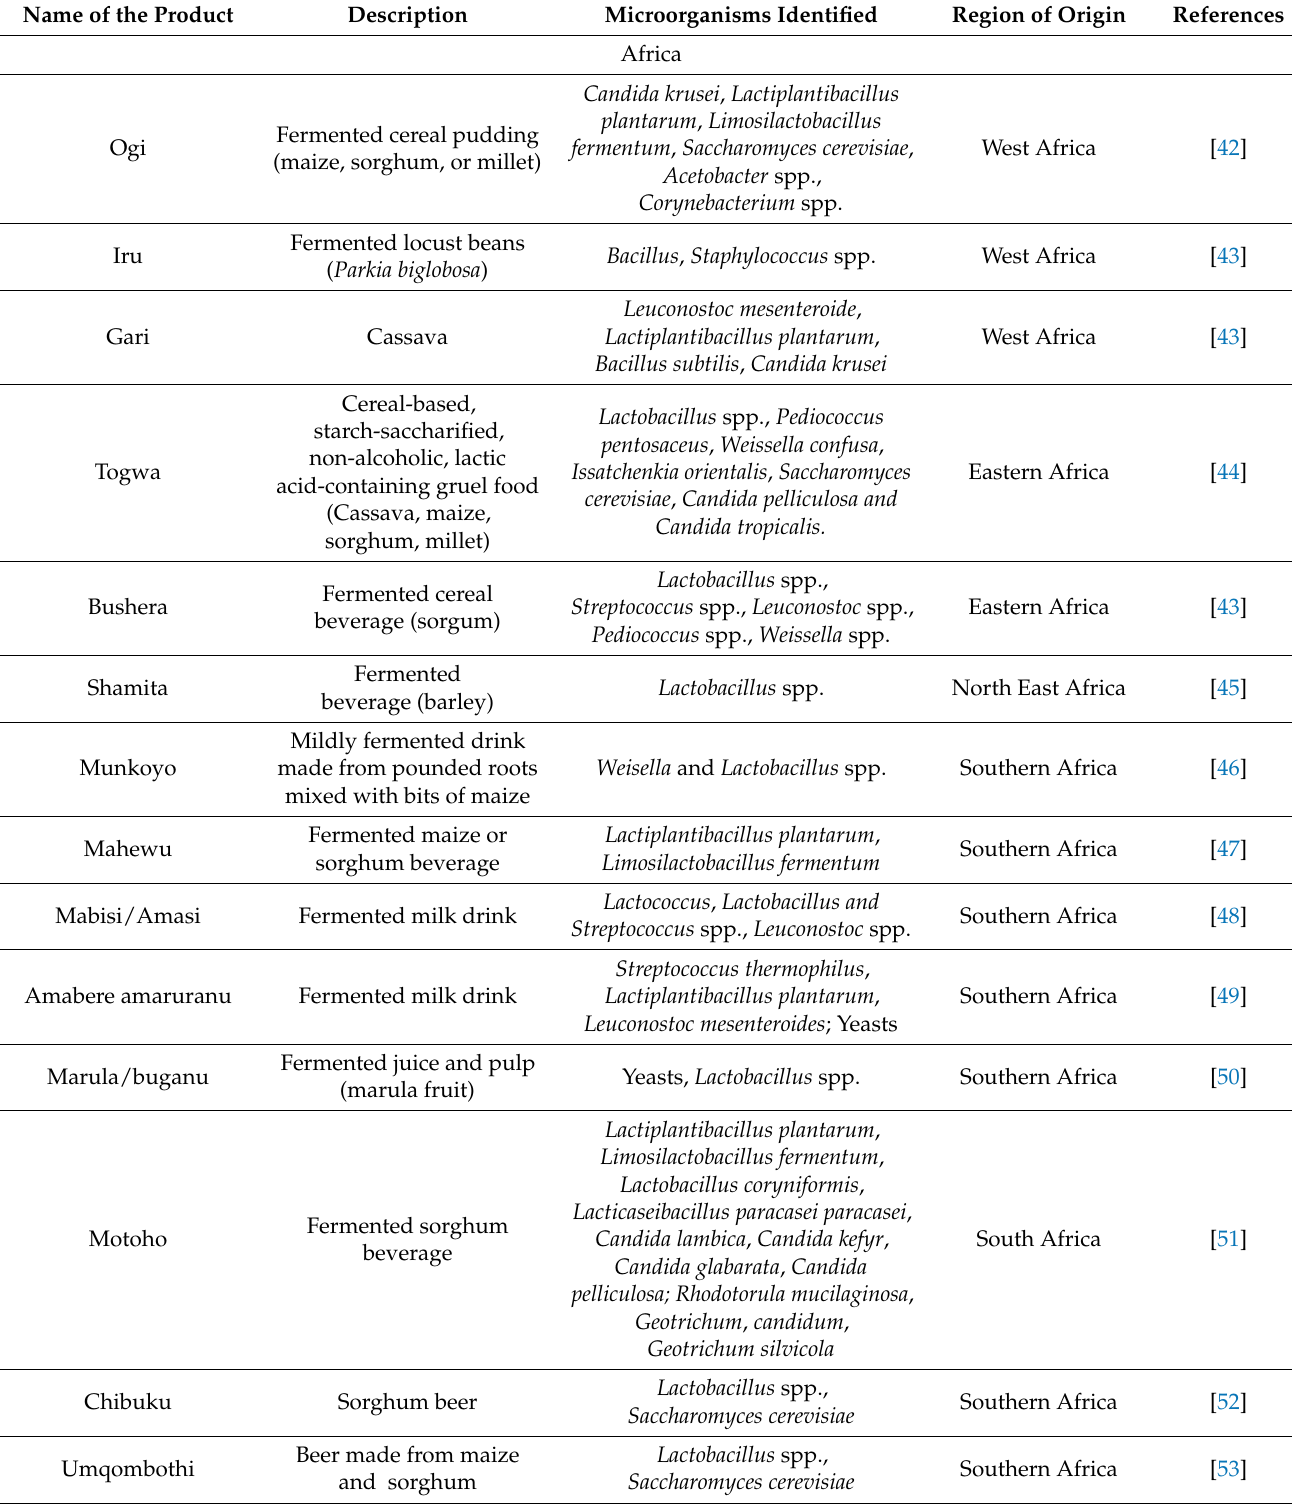
Table 1. Microorganisms found in common fermented